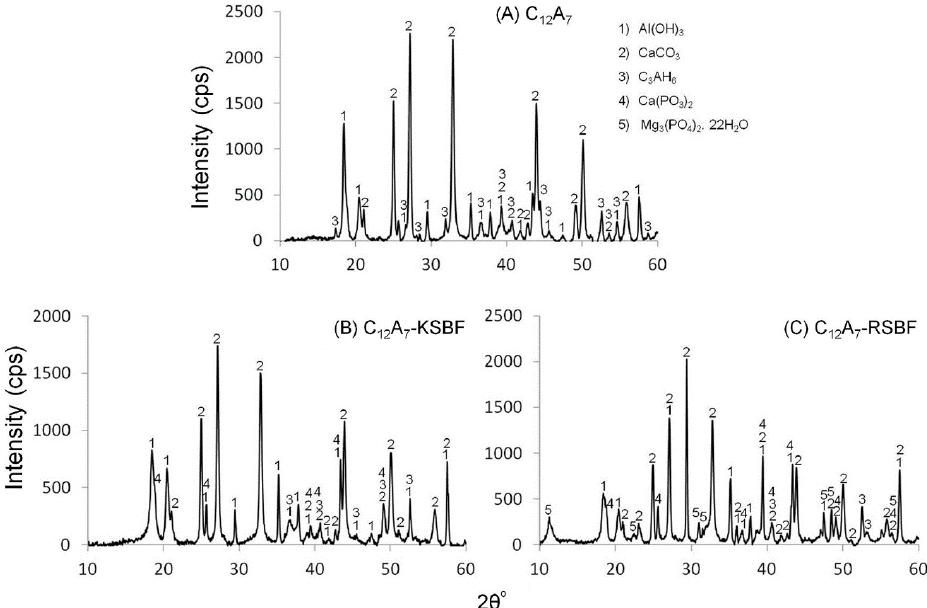
Figure 8. XRD patterns of C